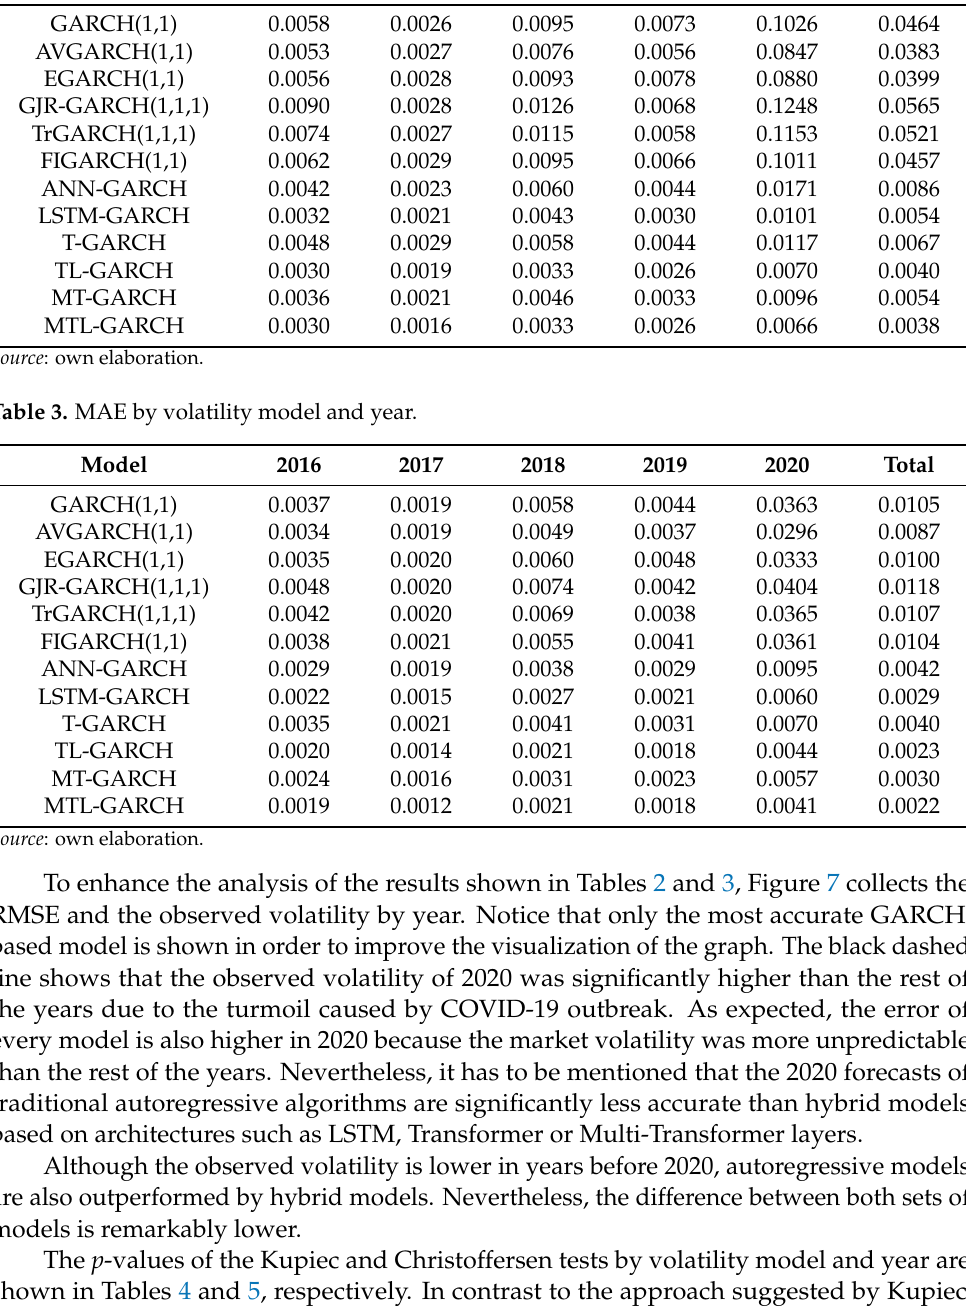
Table 2. RMSE by volatility model and year. Model